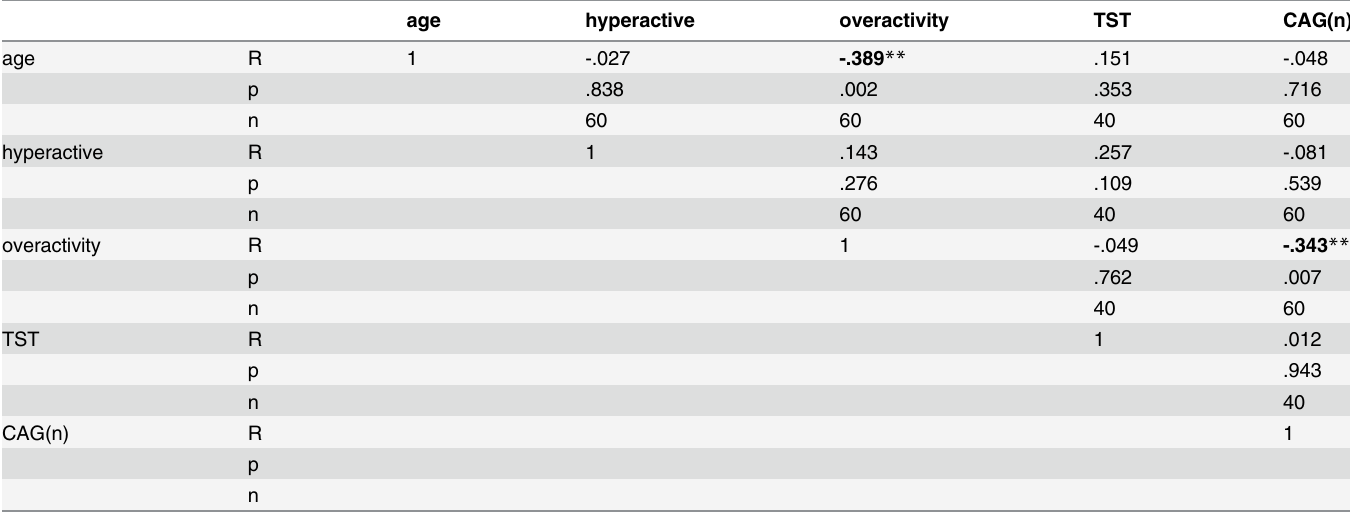
Table 2. Correlation matrix table including Pearson correlation coefficient (R) and sample size n with the variables analyzed in groups of boys with